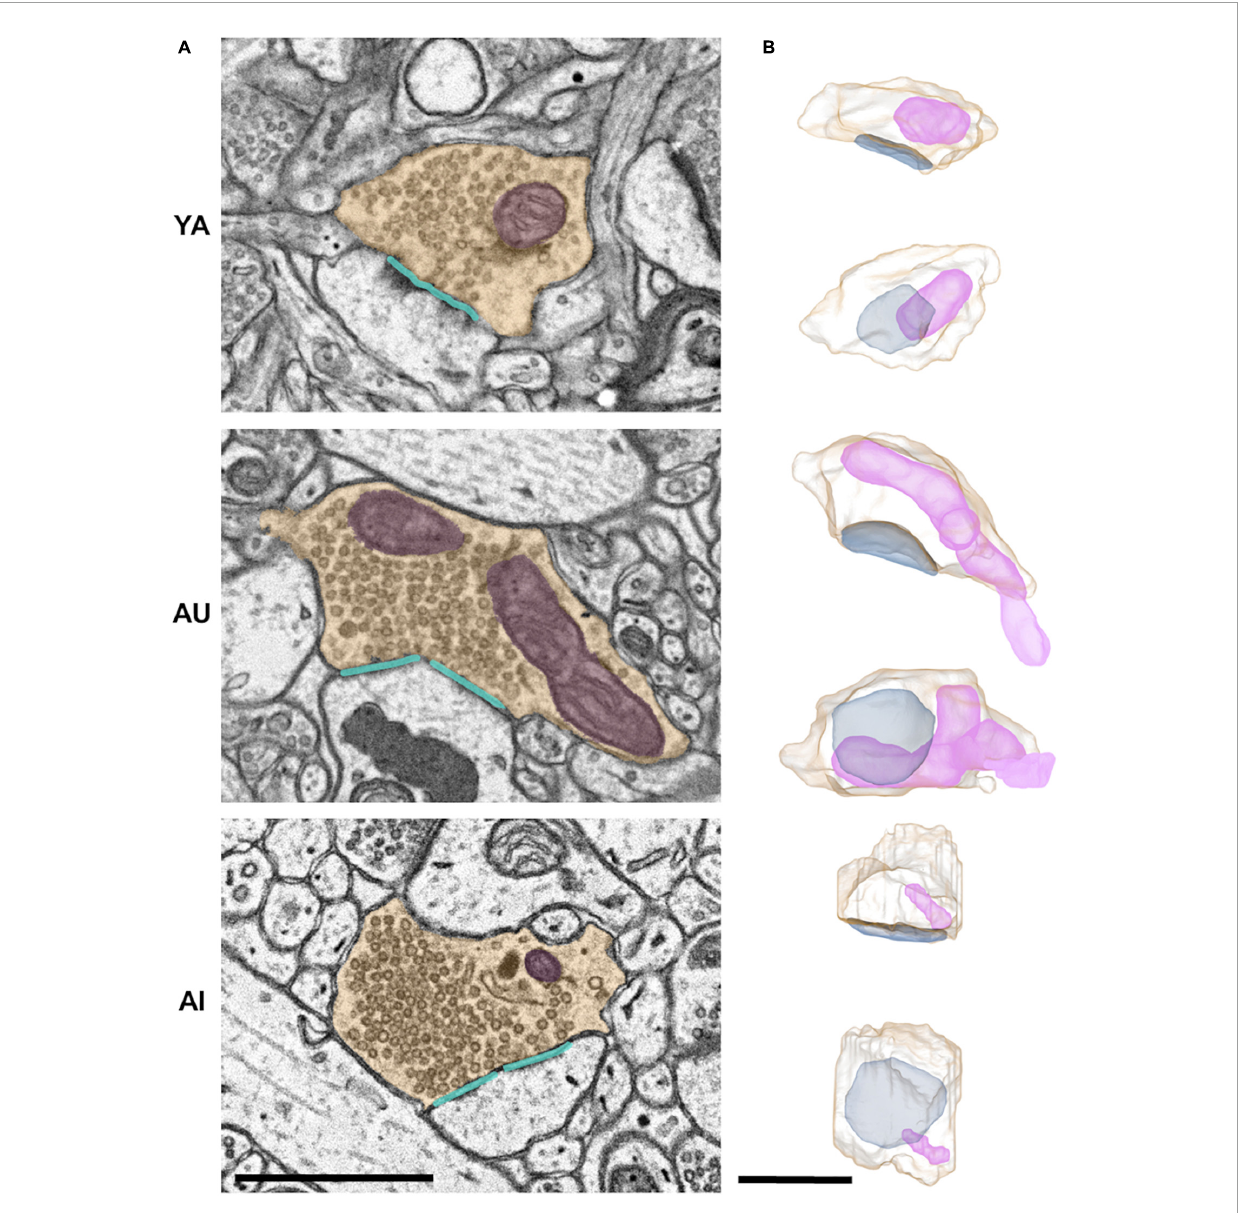
FIGURE3 Synaptic complex segmentations and reconstructions. (A) Two-dimensional segmentations, and (B) paired orthogonal projections of representative synaptic complexes from the young adult (YA; top row), aged unimpaired (AU; middle row), and aged impaired (AI; bottom row) marmosets. Presynaptic boutons are shown in yellow, mitochondria in purple, synapses in cyan. Scale bars are 1 µ m.